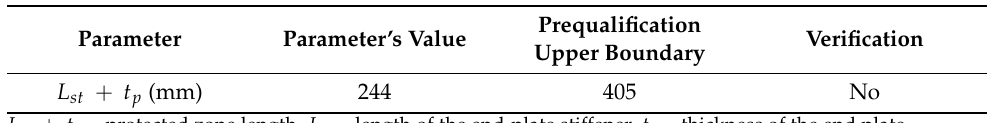
Table 4. Protected zone characteristics vs. prequalification